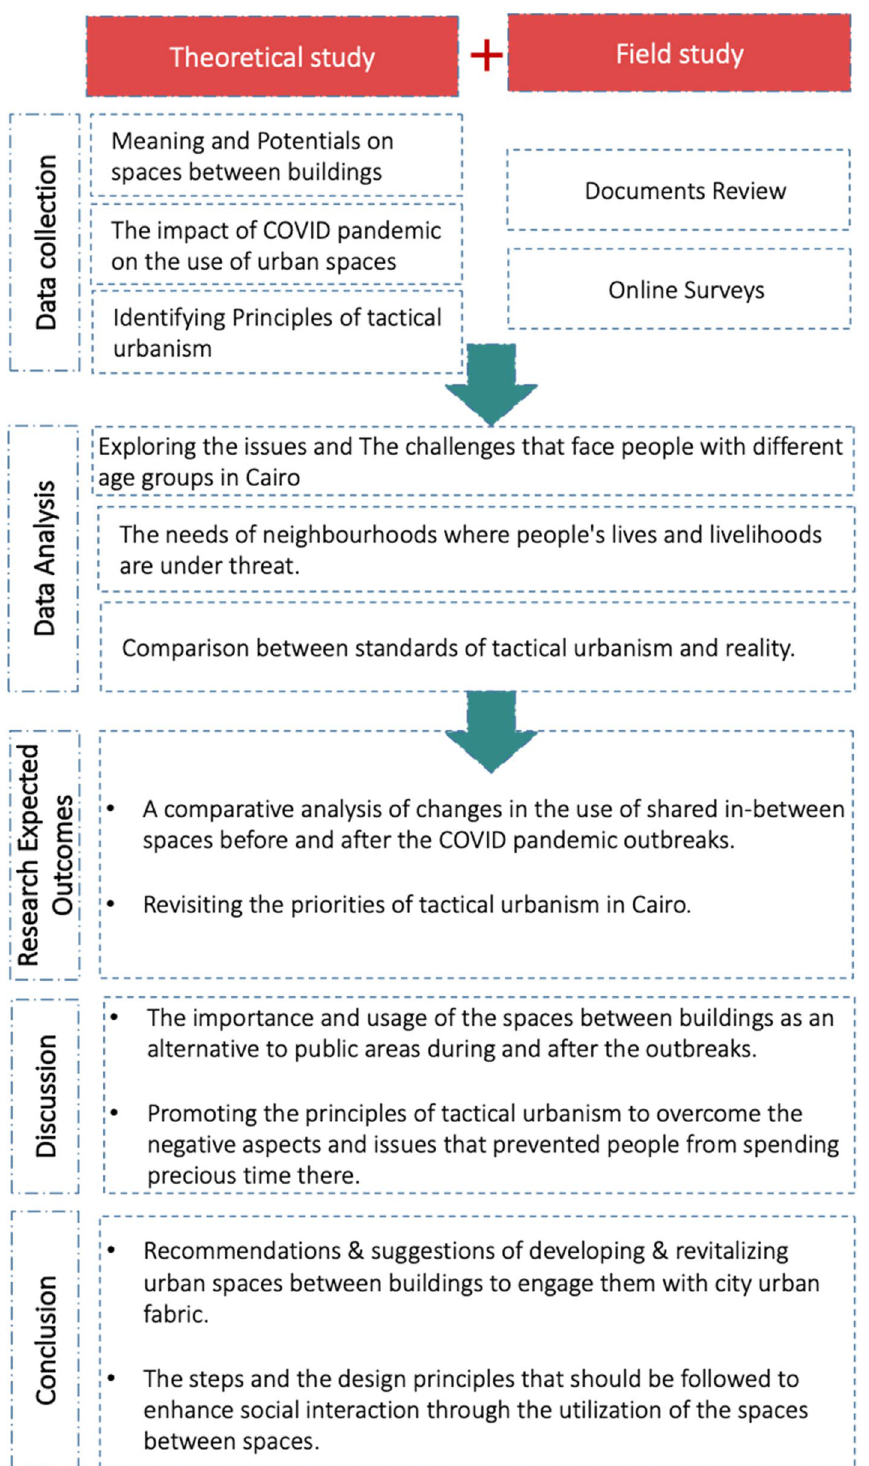
Fig. 3 Research methodology and the analysis of spaces between buildings revitalisation